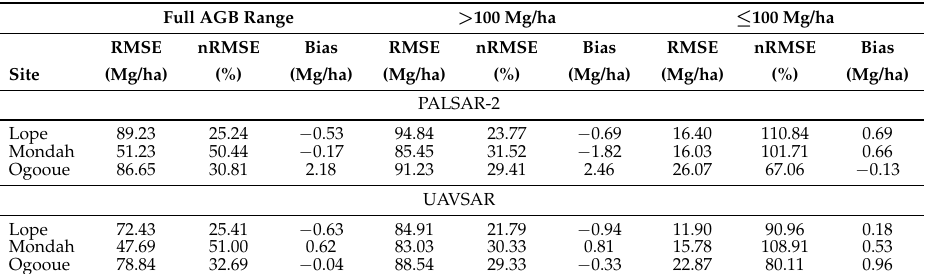
Table 3. Results from our proposed methodology using a high and low AGB mask. Our estimates have 50 m resolution. Full AGB Range > 100 Mg/ha ≤ 100 Mg/ha nRMSE